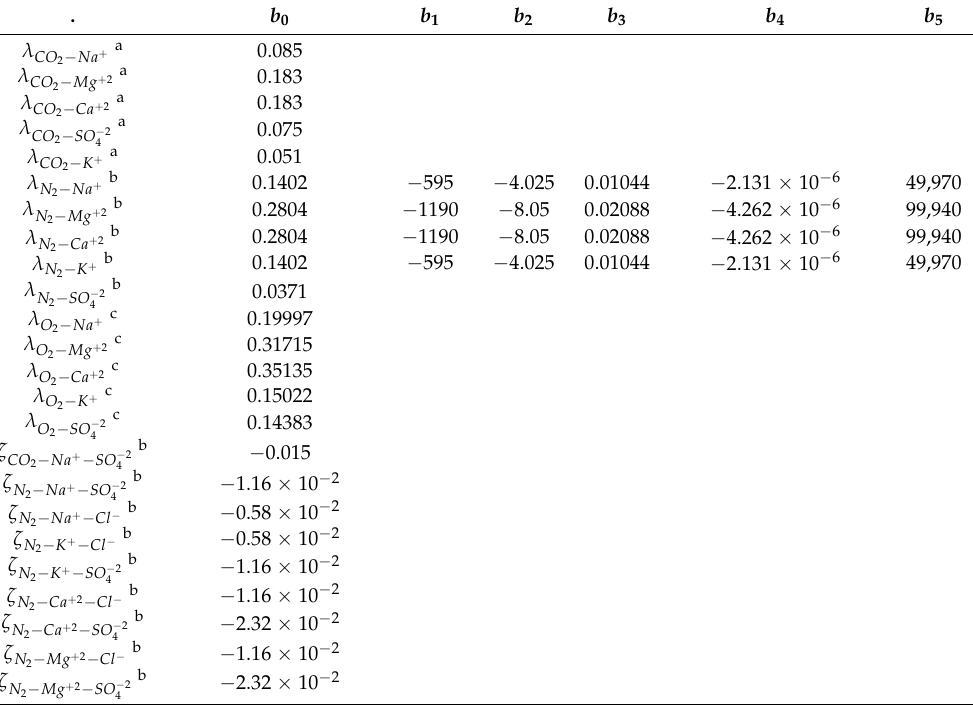
Table 4. Parameters of Pitzer interaction equations for gas components and main ion